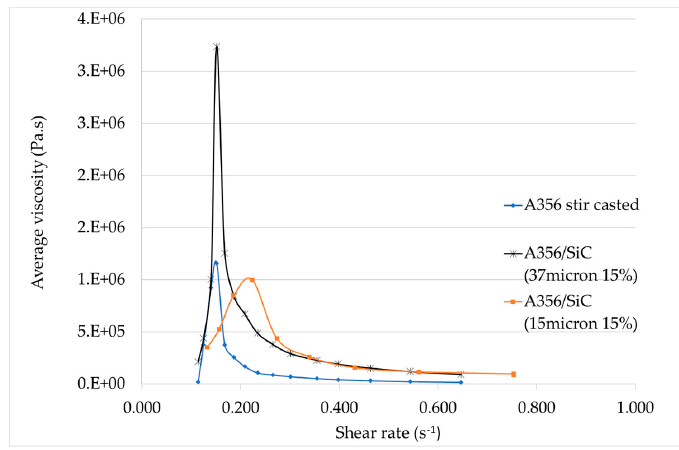
Figure 9. Average viscosities against shear rate of A356, A356 / SiC feedstock ( 15%SiC - 37µm), and A356 / SiC feedstock ( 15%SiC - 15µm ) . A356 / SiC feedstock (15%SiC-15 µ